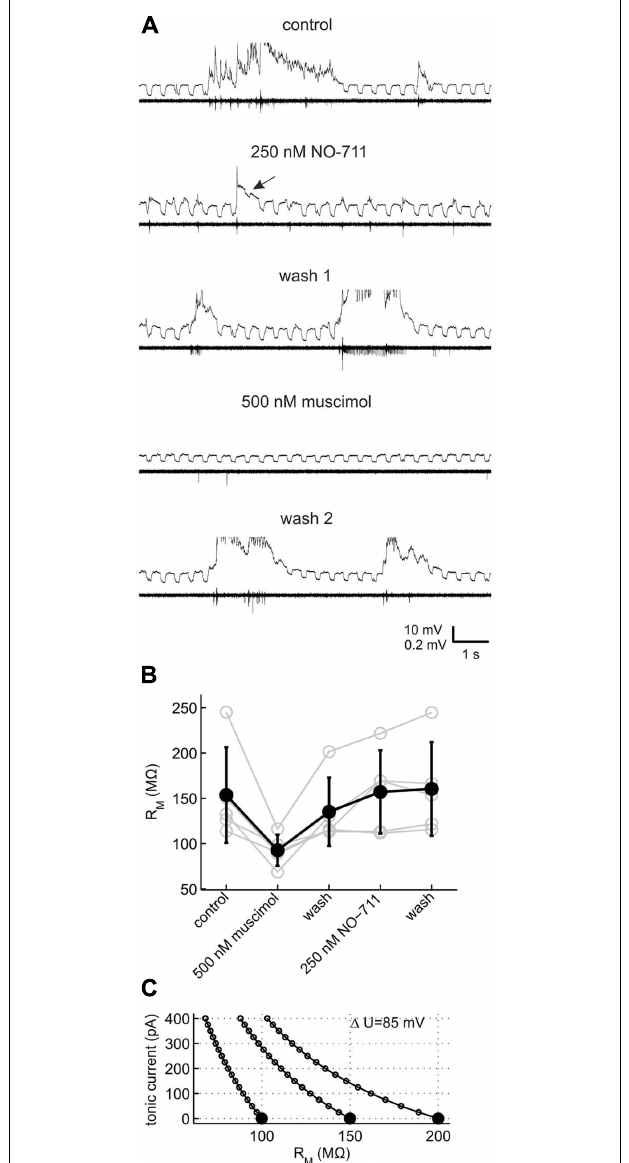
FIGURE 6 | Effects of GAT-1 inhibition and tonic activation of GABA A receptors on neuronal membrane resistance. (A) Example recording of a putative pyramidal neuron (top trace within each pair of traces, R = 150 M (cid:2) ) and multiunit action potential activity on a nearby extracellular electrode (bottom trace) during control and after sequential application of NO-711 and muscimol.The neuron was repetitively injected with a 40 pA rectangular hyperpolarizing current throughout the length of the data excerpts shown.The current traces are clipped to reveal detail of the responses to current injection. Arrow in the second pair of traces from top points to a membrane voltage response which is strongly reduced in the wake of a network burst in 250 nM NO-711. Note the nearly complete absence of spontaneous activity with 500 nM muscimol which recovers after the second washout. (B) Resting membrane resistance of five neurons exposed to both muscimol and NO-711. (C) Simplified theoretical relationship between an observed change of resting membrane resistance (abscissa) and the underlying tonic conductance, expressed in terms of the tonic current at an assumed ionic driving force of 85 mV. Curves are shown for three neurons with different initial resistances (full